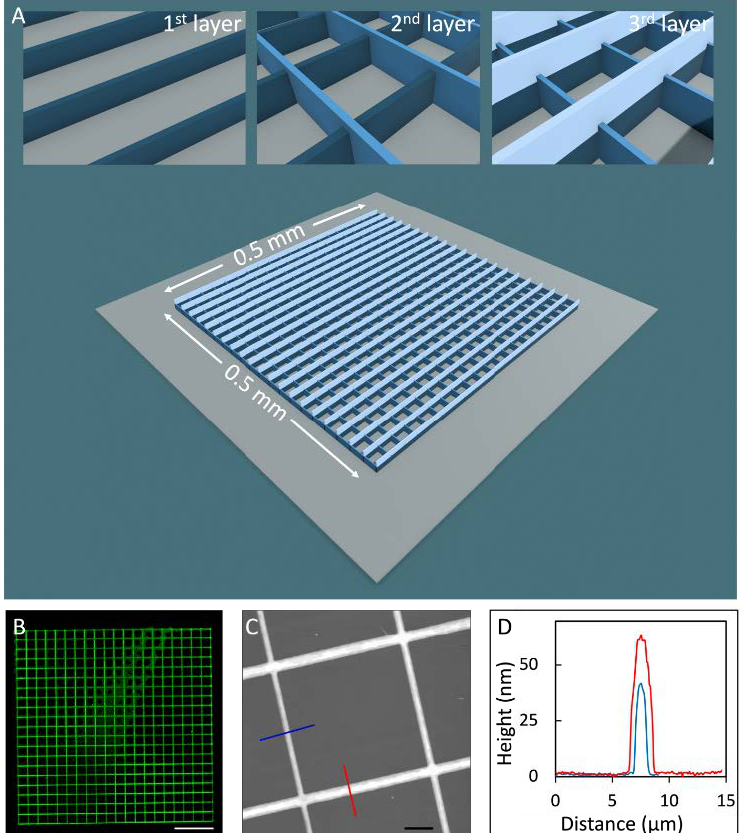
grid. The widths of the single- and double-layered grids, characterized from the cursor profile (FWHM), measured 1.0 ± 0.1 and 1.7 ± 0.1 µ m, respectively, as shown in Figure 4C. The heights were 46.3 and 61.1 nm for the single- and double-layered grids, respectively. Histogram analysis was also carried out on multiple randomly selected areas (0.5 × 0.5 mm) of which the single- and double- layered heights were 45.2 ± 1.2 and 61.6 ± 0.7 nm, respectively. The grids appeared homogeneous, as the uncertainty was relatively small for these nanometer features. The second path led to wider and shorter grids than those of the first pass. These observations can be rationalized by the higher degree of droplets spreading during the printing of the third-layer grids. The apex of the probe due to the printing of two layered grids was coated by the lipid molecules and as such increased the transient droplet spreading during the delivery. This explanation was confirmed by printing a linear feature at the end of the experiment and comparing its width with the first grid layer. The feature width exhibit an increase in comparison to that using the fresh probe.